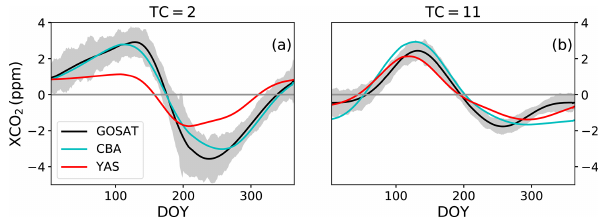
Figure 8. The seasonal cycles of detrended atmospheric XCO 2 at TransCom region 2, the southern part of North America (a) , and region 11, Europe (b) . The grey line shows the standard deviations of the observations after detrending. The observations are in black, CBALANCE (CBA) model results in cyan and Yasso (YAS) model results in red. The solid grey line denotes the zero line, and DOY denotes day of